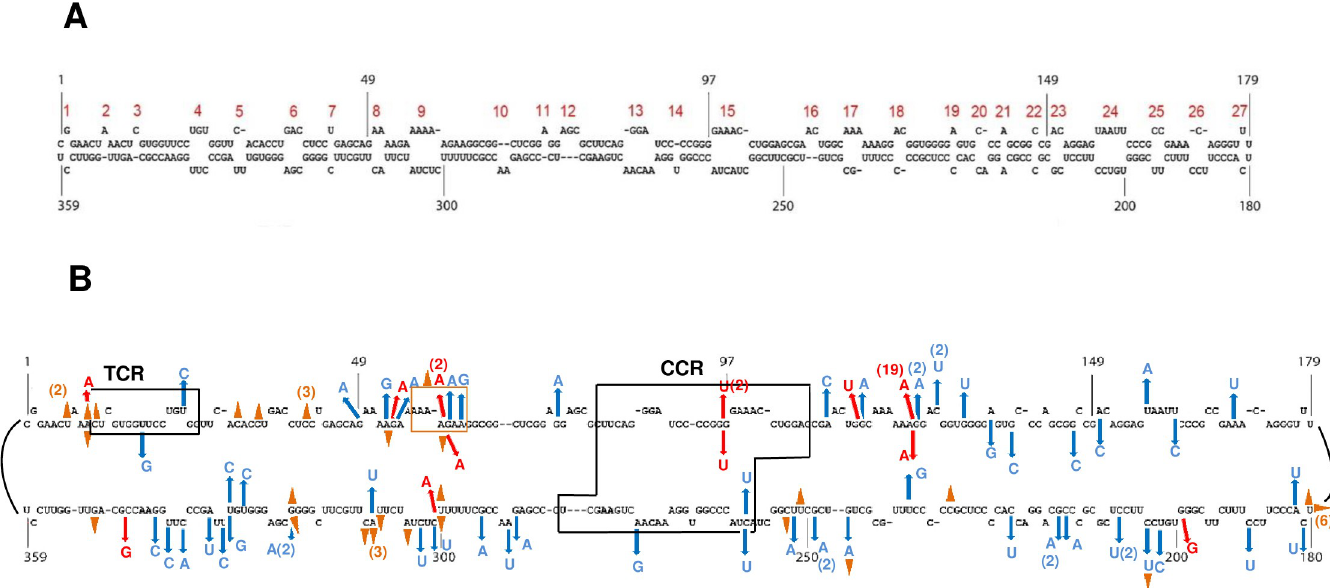
Fig 5. Comparison of mutations identified from PSTVd (-)-strand dimer sequencing and deep sequencing variant progeny. (A) Secondary structure of the (+)-strand PSTVd genome. Nucleotide coordinates are indicated and loops/bulges are numbered 1 to 27 (red). (B) Mutations were mapped to genomic (+)-strand PSTVd. Mutations identified from dimer sequencing are indicated to the outside of the PSTVd secondary structure, and mutations identified by deep sequencing PSTVd progeny populations are indicated to the inside. Progeny mutations shown were shared by more than 10 unique sequences per million reads. Blue arrows indicate base substitutions, red arrows indicate base insertions, and brown triangles indicate base deletions. A deletion of seven consecutive bases is indicated by a brown box. Numbers of occurrences are indicated in parentheses. The terminal conserved region (TCR) and central conserved region (CCR) are outlined by black boxes.